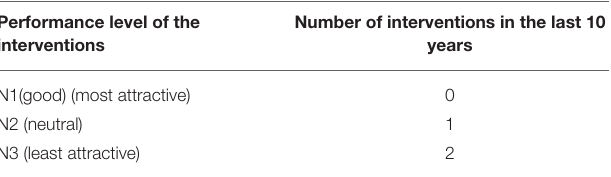
TABLE 5 | Performance scale of the interventions relative to the number of interventions in the last 10 years. Performance level of the